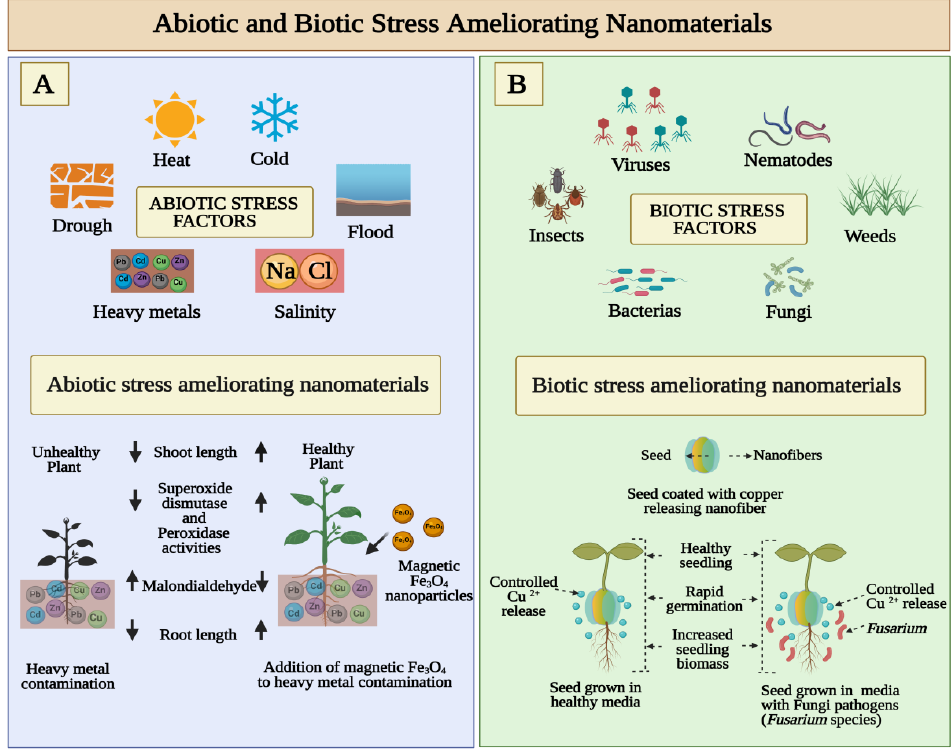
Figure 3. Effect of nanopriming agents to improve seed germination in abiotic and biotic stress con- ditions. ( A ) Environmental conditions in combination with soil quality may pose stress to different phases of seed germination affecting biochemical pathways involved in the root-shoot develop- ment. The metal chelators and biocatalytic NPs could play a rescue role mitigating those abiotic conditions, giving a healthy plant development. ( B ) Seed nanopriming with broad spectrum NMs with known microbicidal and anti-parasitic effect improve seed germination in biotic stress condi- tions boosting overall crop yield.